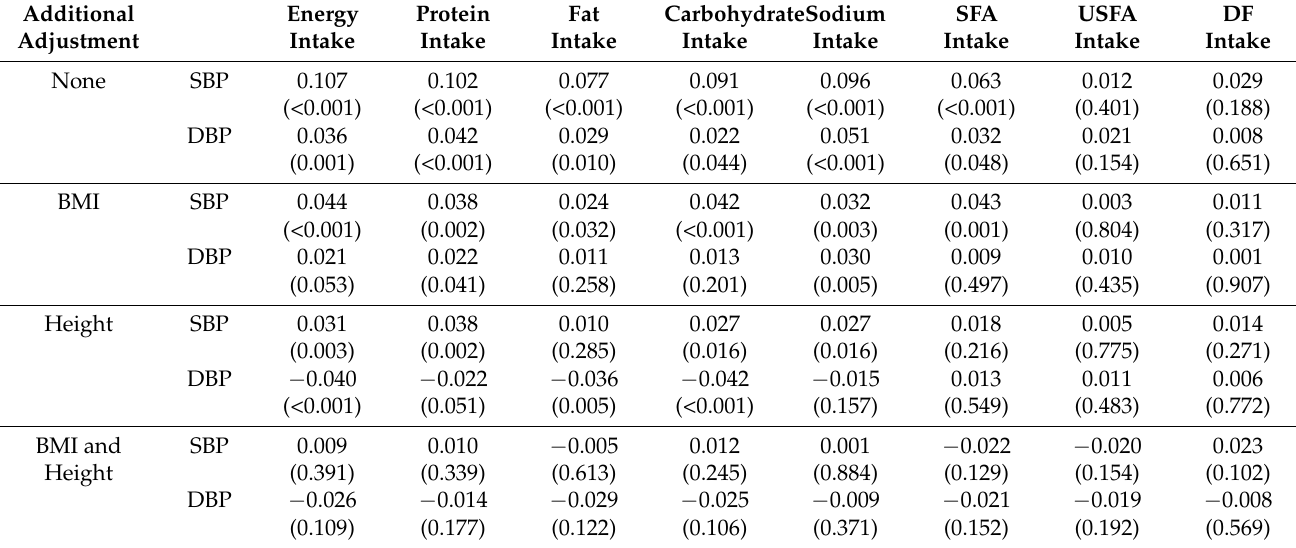
Table 4. Correlation between blood pressure and nutrition intake with adjustments for sex and age. Data expressed as correlation coefficient ( p